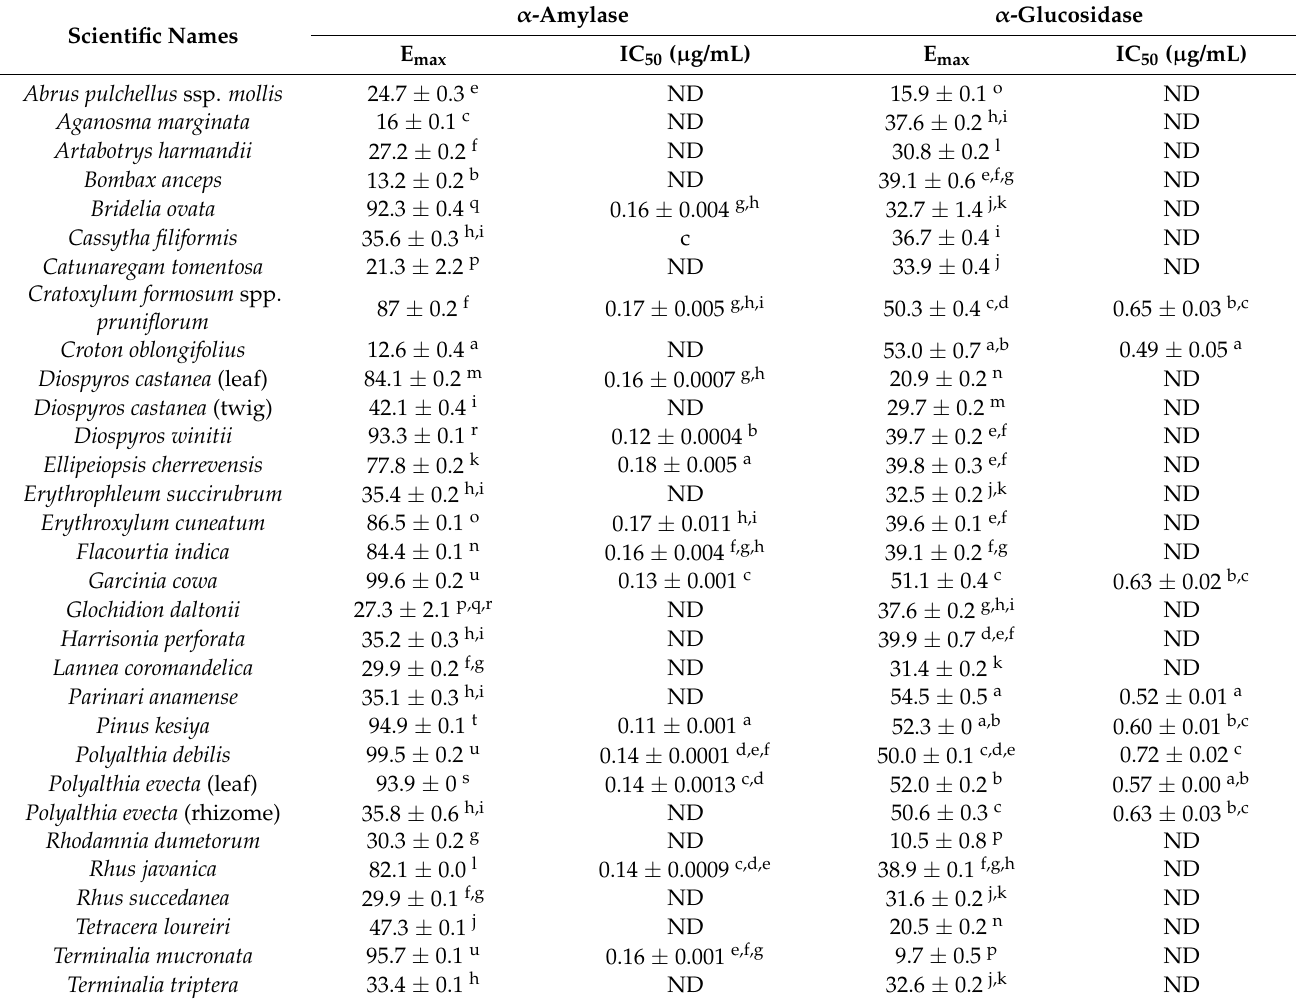
Table 2. α -Amylase and α -glucosidase inhibitory activities of 31 TTM plant samples. The E max is the maximum %inhibitory activity of the highest concentration of TTM extract. The maximum concen- trations used for the inhibition of α -amylase and α -glucosidase were 2.75 µ g/mL and 0.67 µ g/mL, respectively. IC 50 is the 50% inhibition concentration of